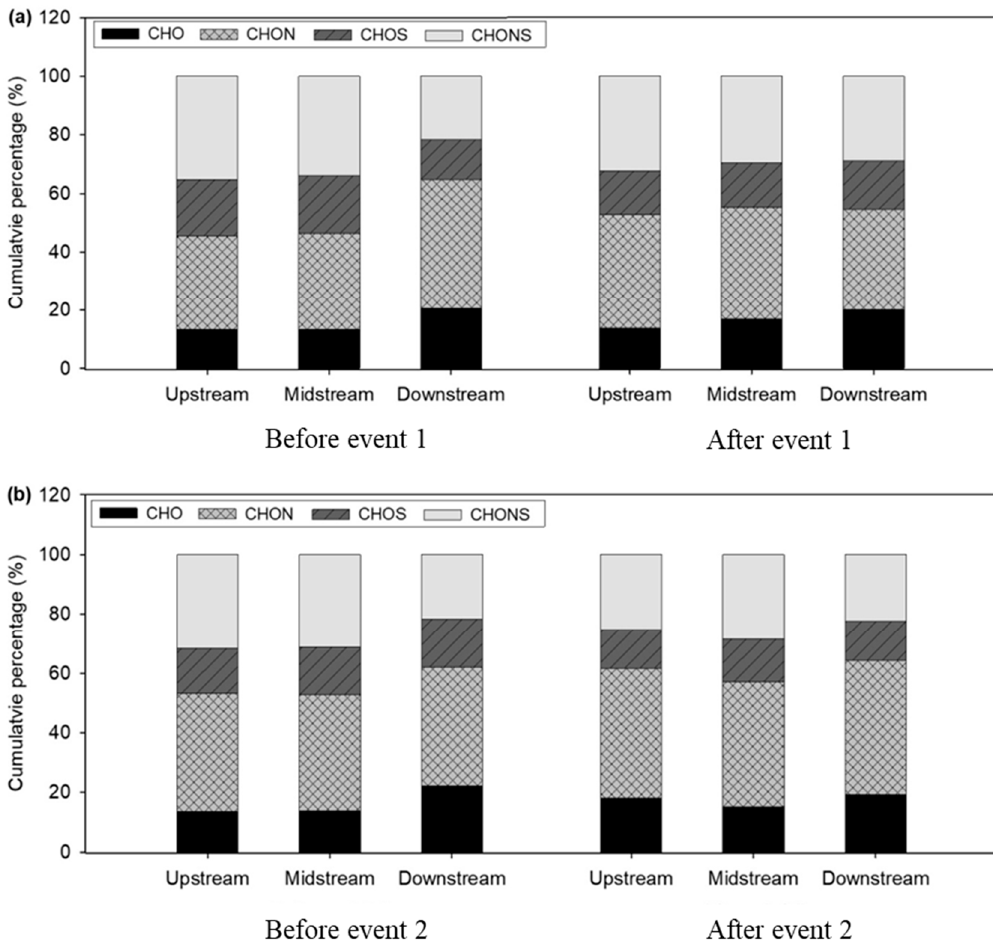
Figure 8. Element compositions of DOMs at each sampling point in ( a ) Event 1 and ( b ) Event 2.